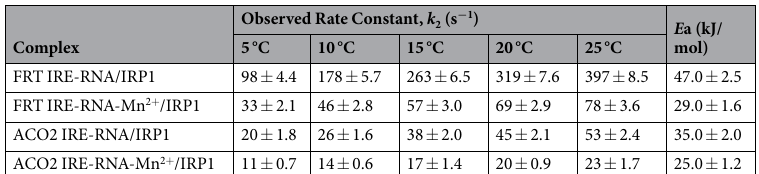
Table 3. Temperature dependent kinetic rate constants for the interaction of FRT and ACO2 IRE-RNA with IRP1 in the absence and presence of 50 µ M Mn 2 +